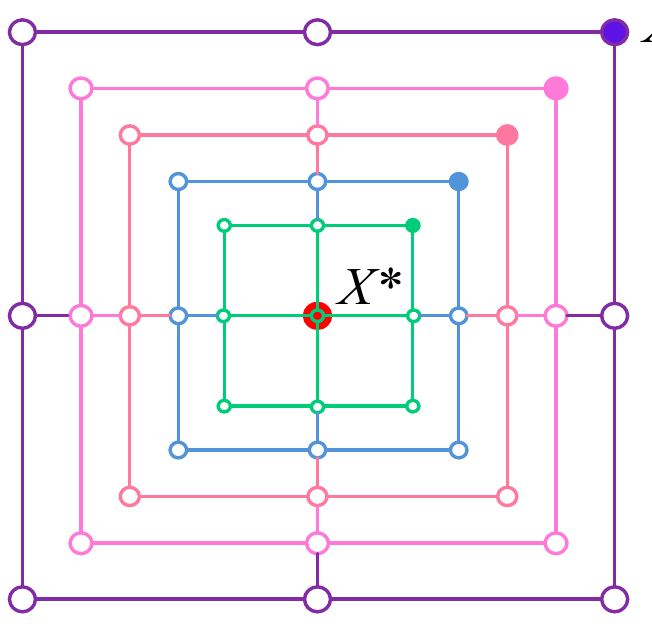
Figure 1. Shrink surround mechanism surrounds hunting.